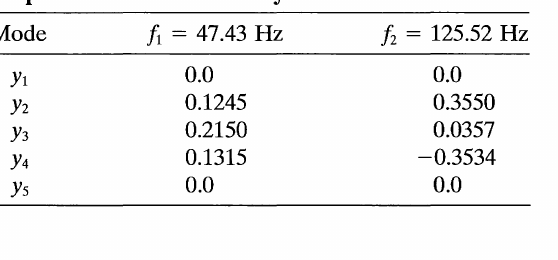
Table 2. Measured Natural Frequencies and Mode Shapes of Multidisk Rotor System